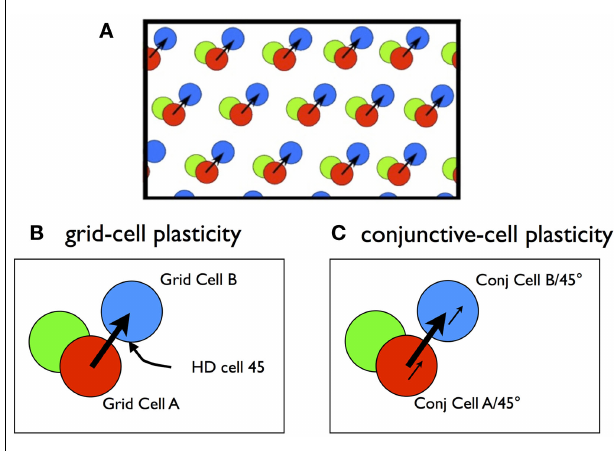
FIGURE 7 | (A) Fixed spatial relations between the activity bumps of three grid cells in a rigid module. (B) Preliminary Hebb model. Grid Cell A + Head-direction Cell 45, firing together, will predict the firing of Grid Cell B.While this is correct, the strengthening of these synapses will not be helpful in predicting the firing of Grid Cell B.The logic requires a conjunctive firing of the two upstream cells (see text). (C) Hebb model with conjunctive cells. In this case the firing of conjunctive cell A/45˚ predicts the firing of conjunctive cell B/45˚. If the synapse has plasticity following Hebbian rules, the synapse ought to strengthen with experience and lead to predictive